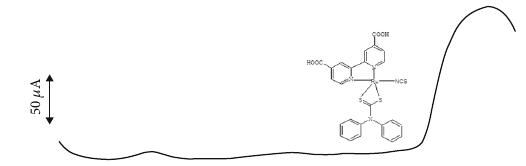
Figure 12: Square wave voltammogram of FC